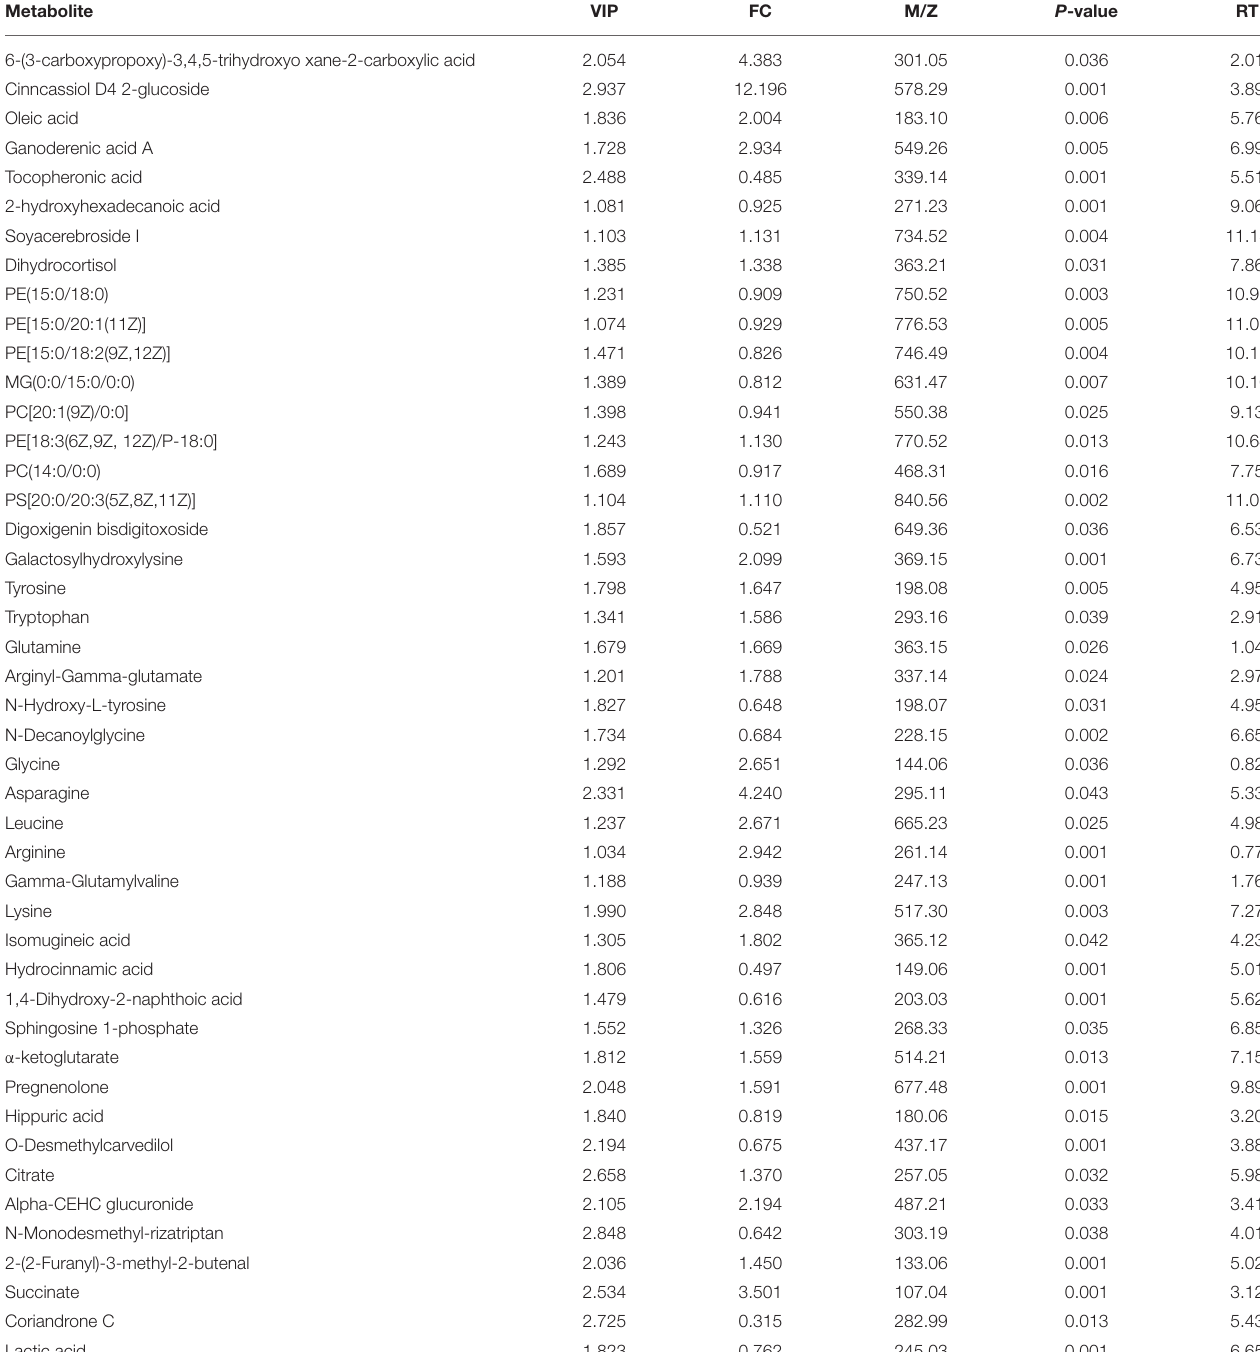
TABLE 3 | Identification of significant differential metabolites in heifer serum by comparison of the concentrate and forage groups using a VIP threshold of 1 ( P < 0.05). Metabolite